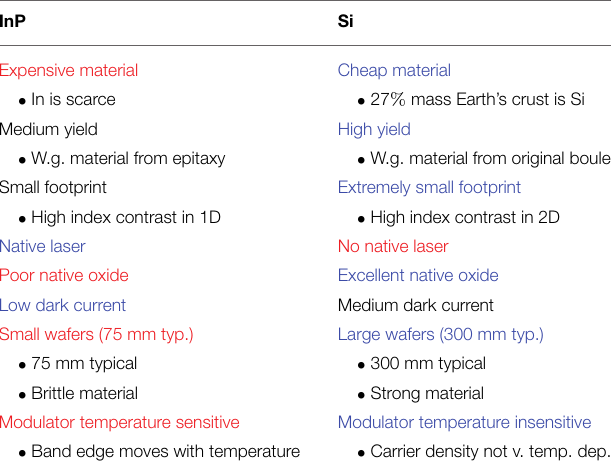
TABLE 2 | Pros and cons of InP and Si for photonic integrated